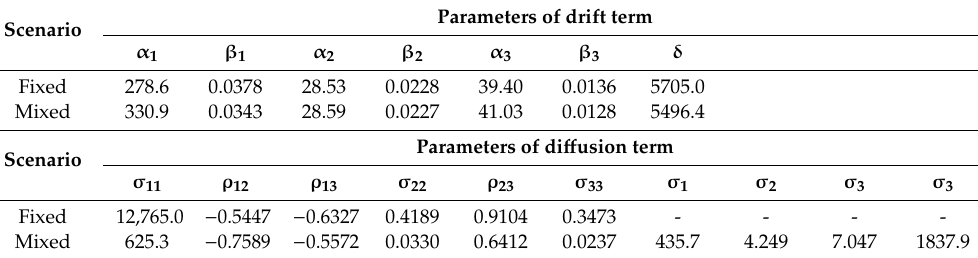
Table 1. Estimates of fixed e ff ect